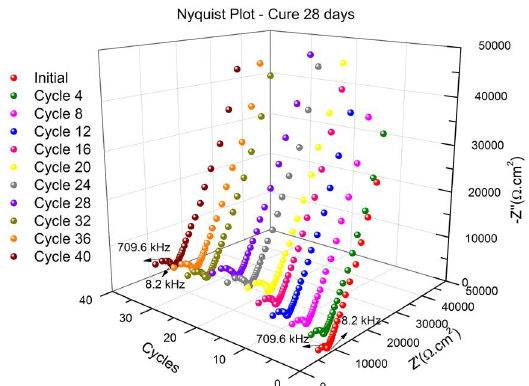
Figure 5. Nyquist Diagram - Cylindrical CC, cured for 28 days and submitted to 40 wetting and drying